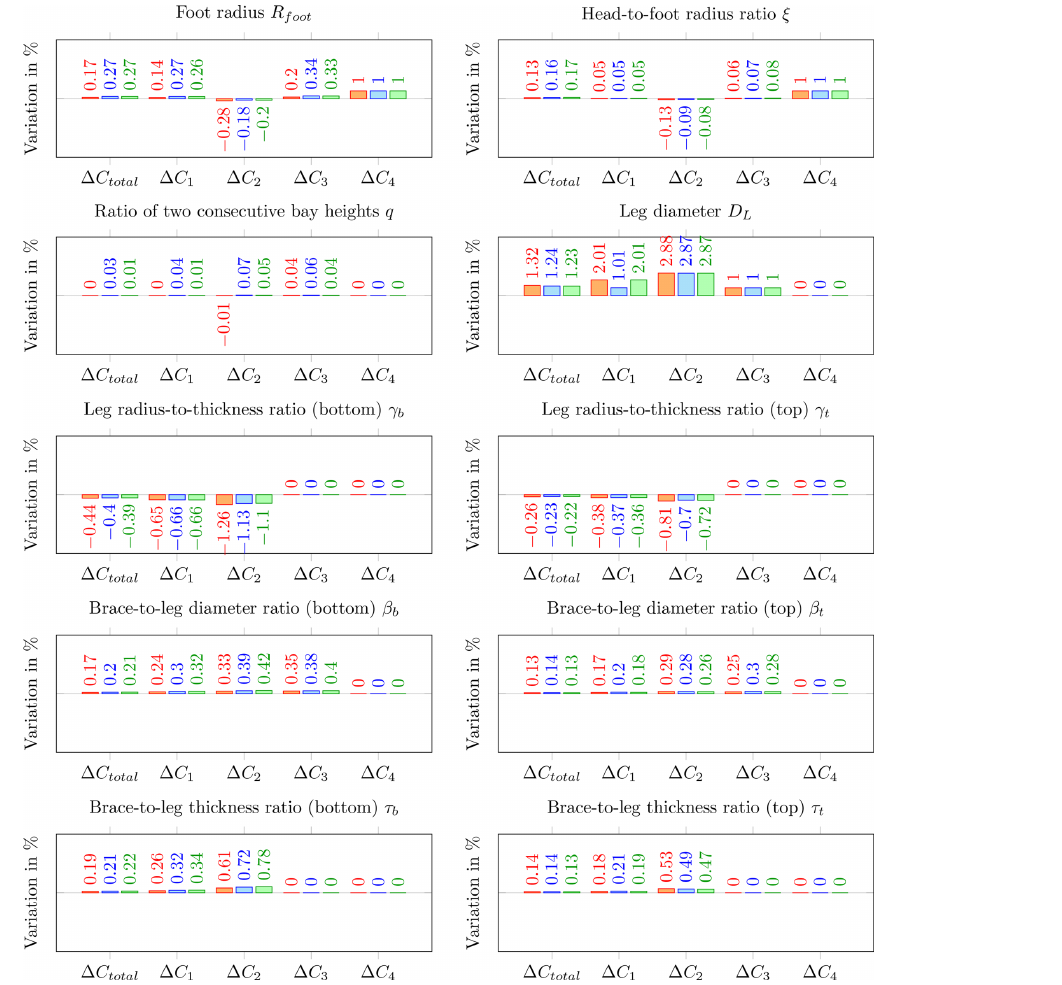
Figure 4. Variations in total costs, (cid:49)C total , and cost function terms (cid:49)C 1 (material), (cid:49)C 2 (manufacturing), (cid:49)C 3 (coating), and (cid:49)C 4 (tran- sition piece) due to 1% one-at-a-time variations in design variables (subplots) in %. Derivatives were computed for the initial design (red bars), an intermediate design after 15 iterations (blue bars), and the optimal design (green bars) of the three-legged structure with three bays ( N L = 3, N X =